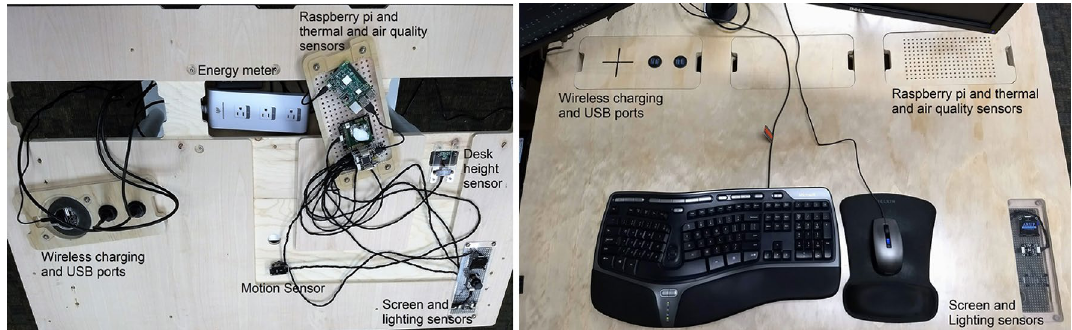
Figure 5. Intelligent workstation with embedded sensors to learn and adapt indoor environment based on user preferences.